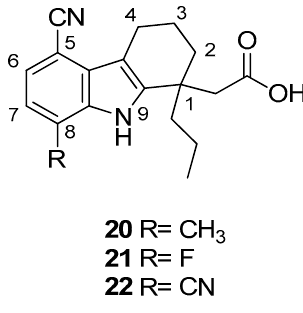
Figure 8. Structures of 2,3,4,9-tetrahydro-1 H -carbazole derivatives 20 – 22 .